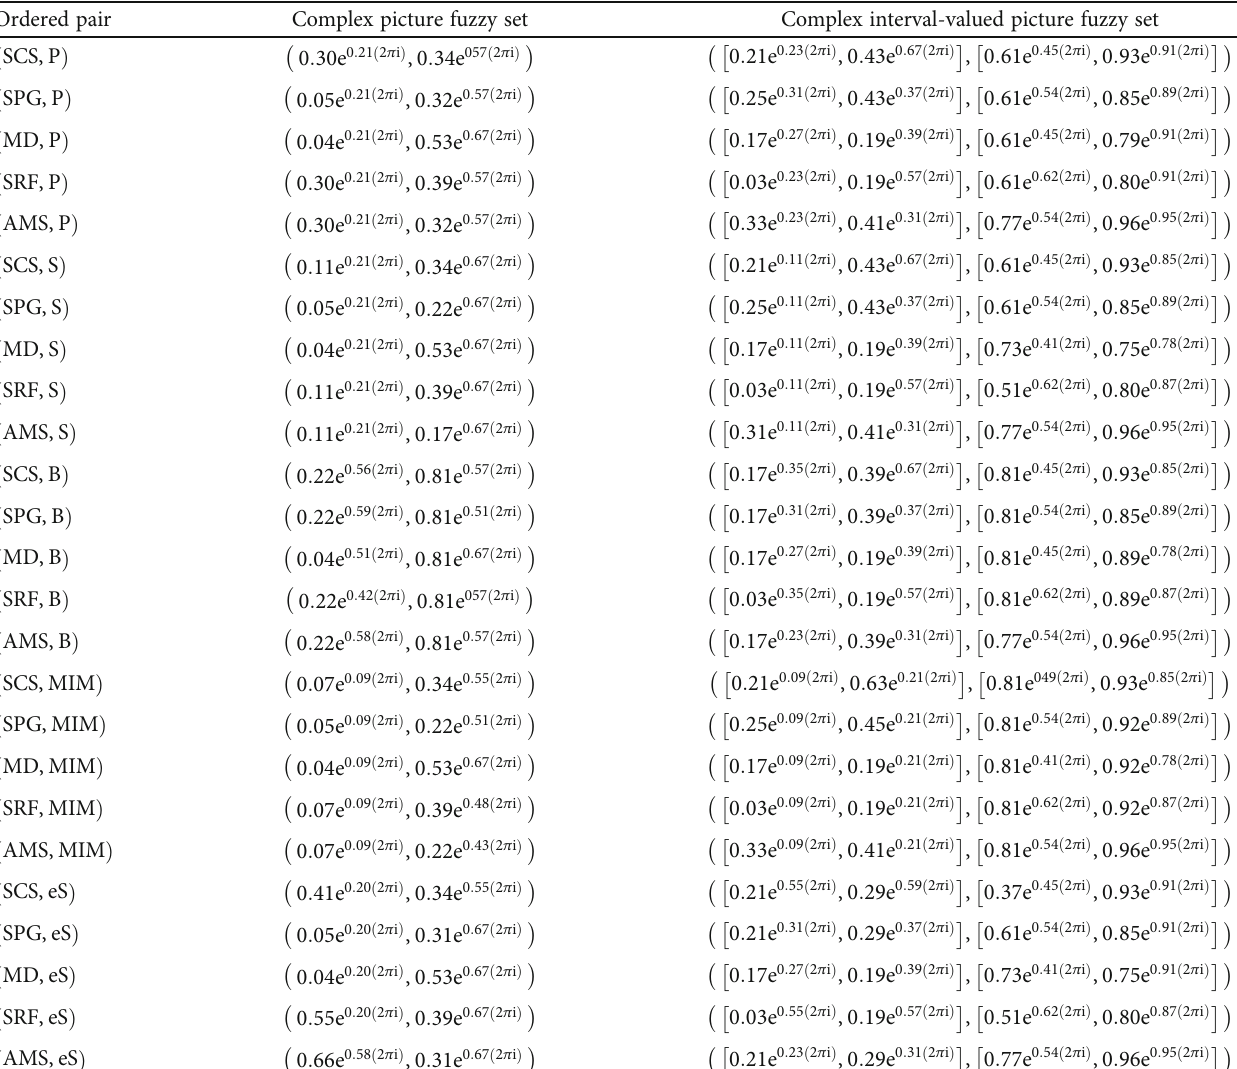
Table 6: Cartesian product I × J . Ordered pair Complex picture fuzzy set Complex interval-valued picture fuzzy set